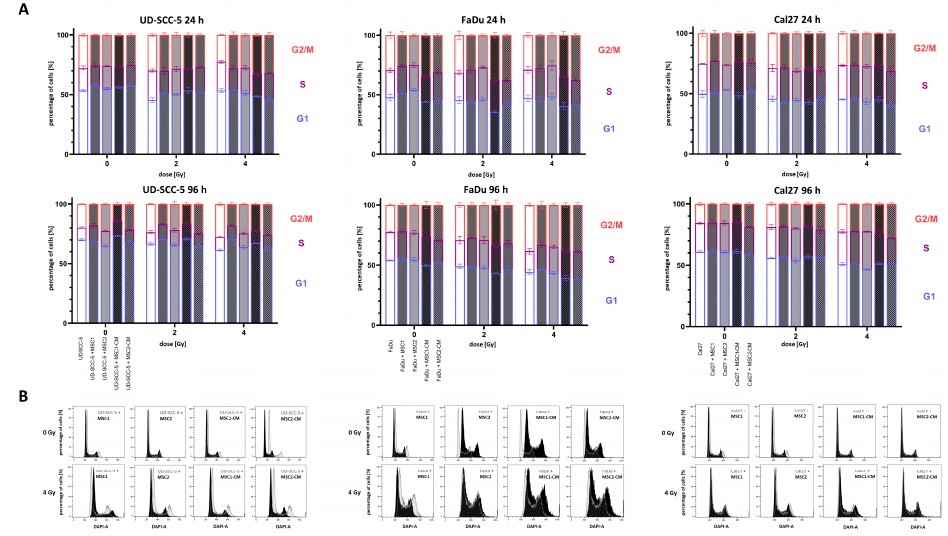
Figure 4. Irradiation-induced G2/M arrest in HNSCCs it not abrogated by MSC co-culturing. ( A ) Cell cycle distribution in HNSCCs at 24 h and 96 h depending on direct or indirect MSC co-culture. Statistics are shown in Figure S3. ( B ) Representative cell cycle histograms of HNSCC mono-culture (grey) or HNSCC-MSC co-culture (black).